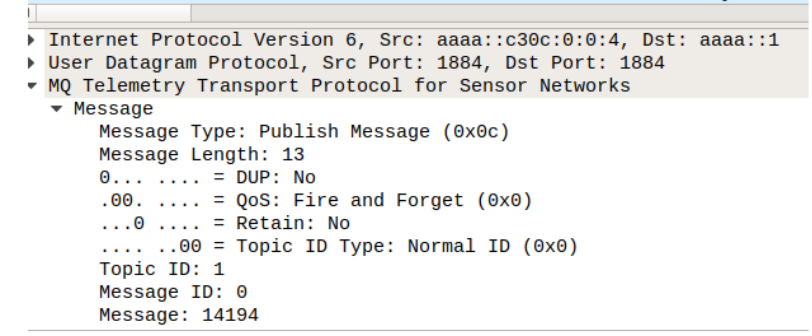
Figure 14. Sniffed pcap view.